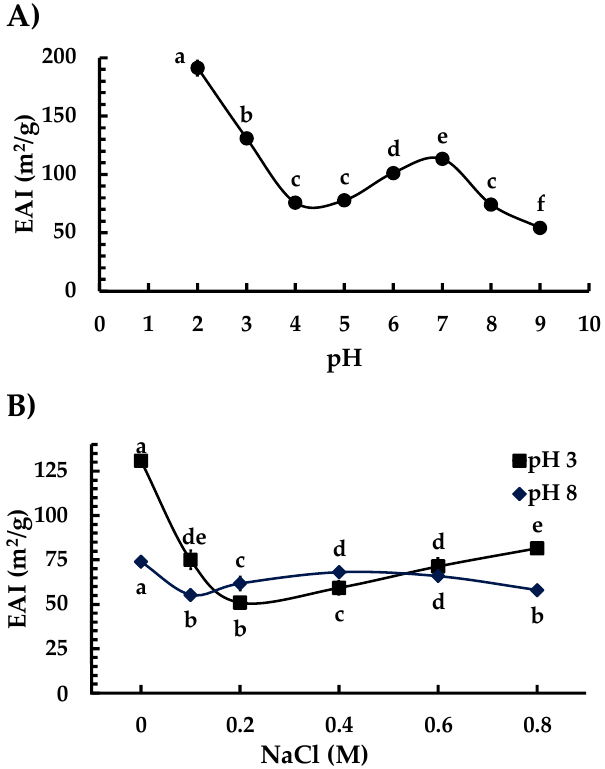
Figure 8. Emulsifying activity indices of Ah11Sn at different pH values ( A ) and concentrations of NaCl ( B ). The letters above or below the legends indicate significant differences at p < 0.05.